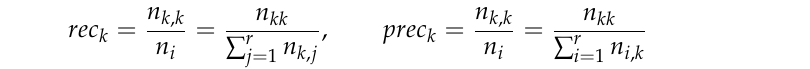
Table 1. Confusion matrix (left) and loss matrix (right) for multiclass classification with r states. Pred. C 1 C 2 . . . C r Obs.